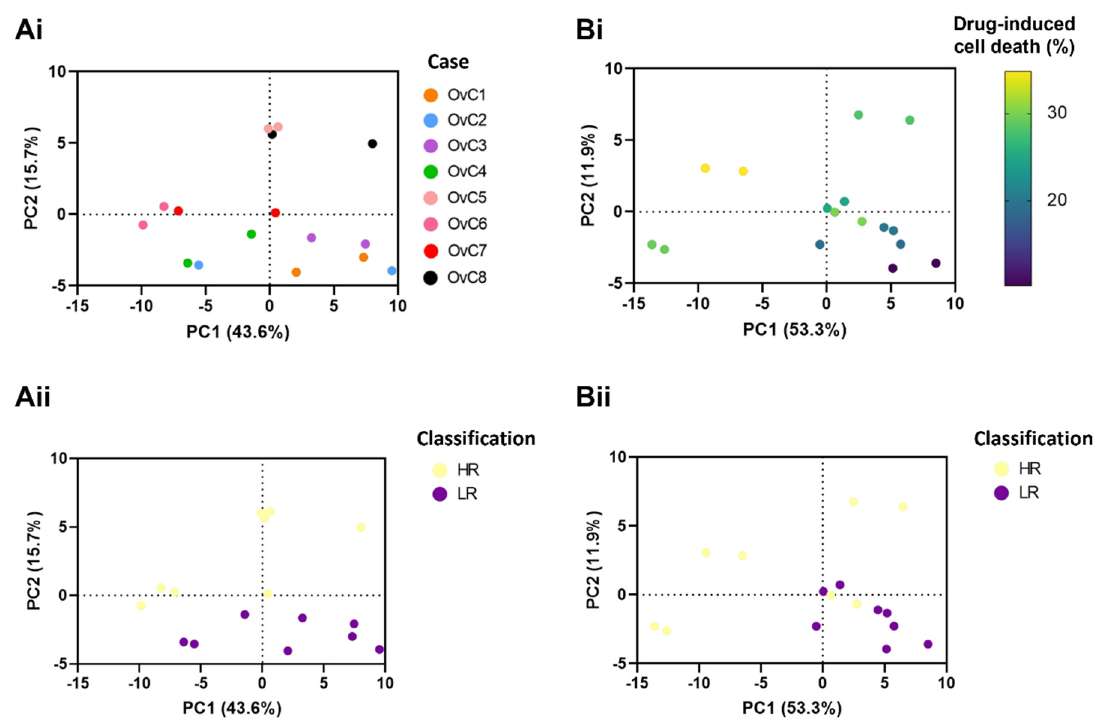
Figure 5. Metabolic footprinting captures metabolic differences between high- and low-responders in untreated controls and combination-treated patient-derived explant cultures. Principal component analysis (PCA) of metabolic footprints of high-grade serous carcinoma (HGSC)-derived explant cultures, at day 14, ( A ) in untreated control conditions predicted different drug response trends by ( Ai ) OvC case and ( Aii ) when categorized by the ex vivo drug response to drug combination. ( B ) In drug combination conditions, PCA revealed drug response trends by ( Bi ) drug-induced cell death after one drug cycle (day 14) and ( Bii ) based on ex vivo drug response categories. (HR: high-responders, LR: low-responders, classified using the drug combination-induced cell death at day 14, with the median as cut-off; PC: principal component).